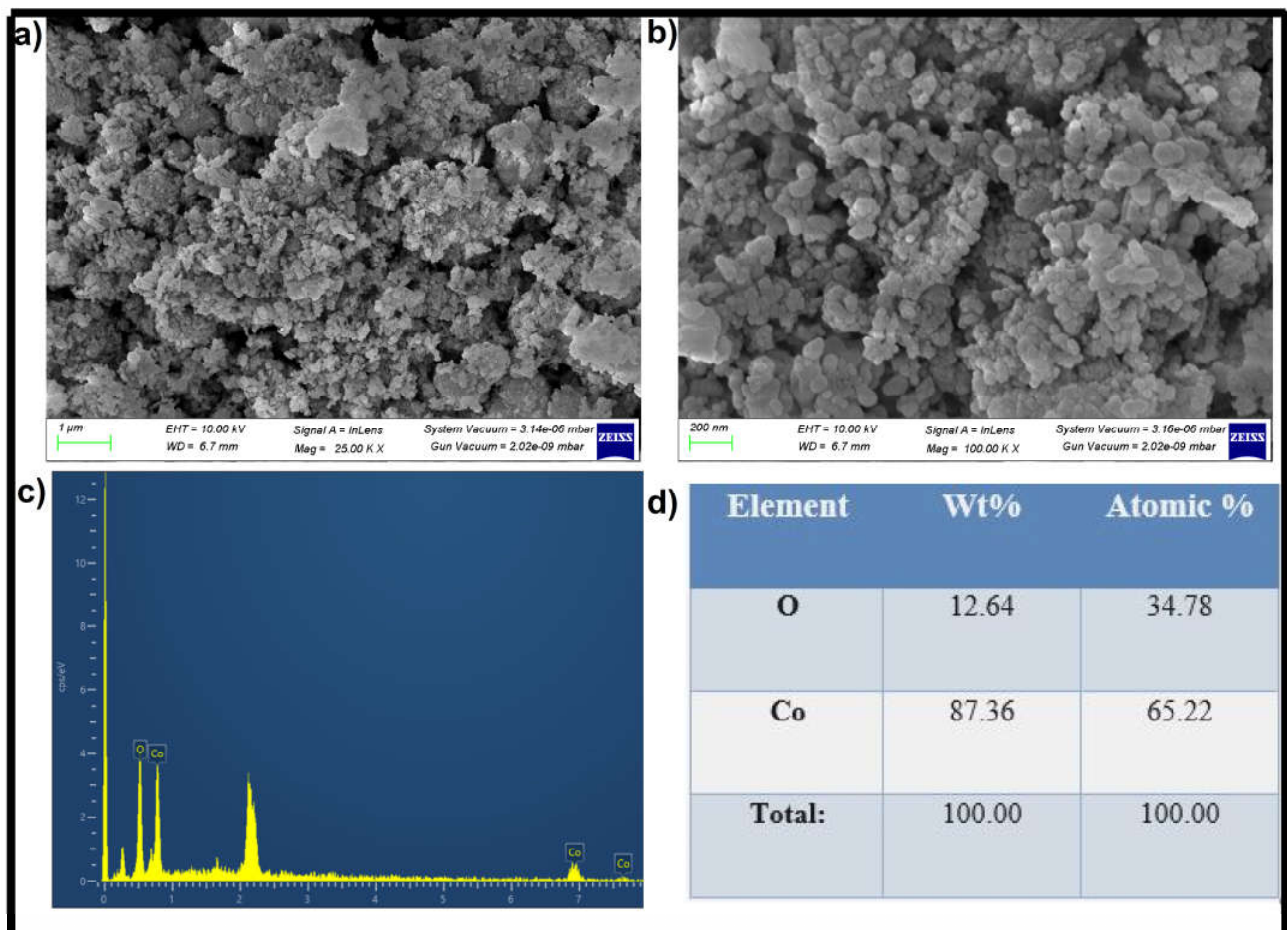
Figure 4. FESEM images ( a , b ), EDX peak spectrum ( c ) and EDX table ( d ) of Co 3 O 4 nanoparticles.